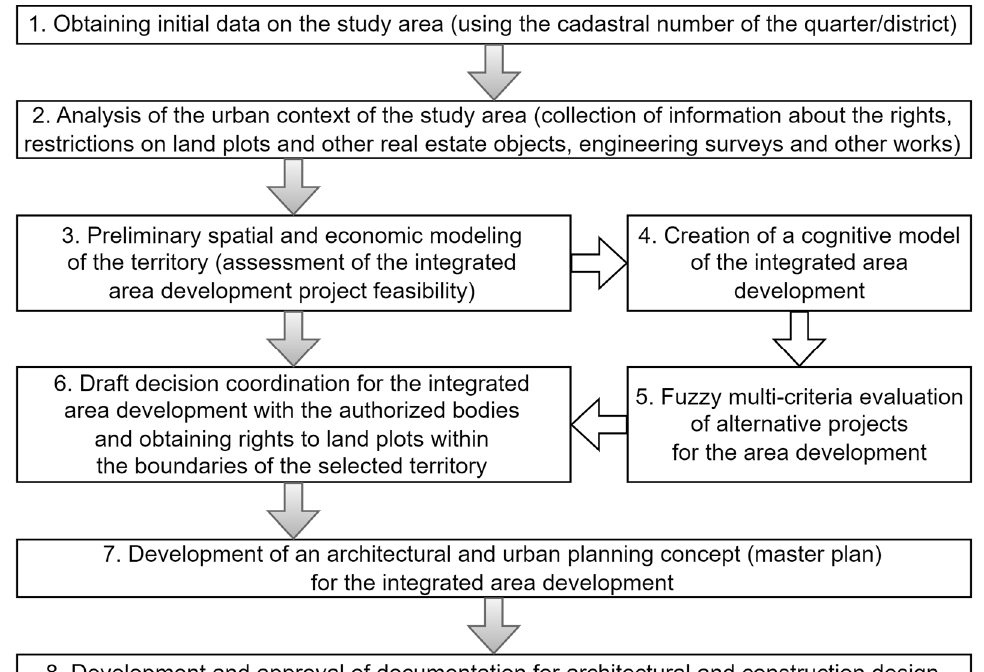
Figure 1. Decision support method in substantiating urban areas development strategies.